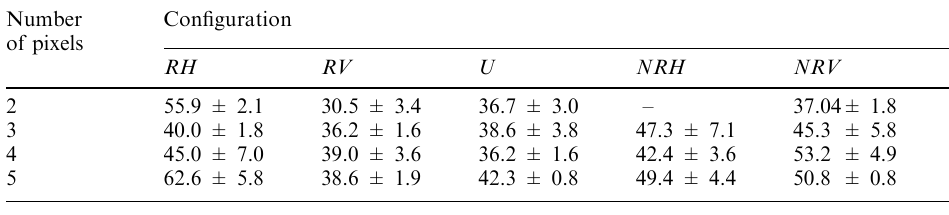
Table 3b. Theoretical average length L and the corresponding standard deviation (in (cid:108) m) for hexagonal columns (note that the volume V of the particle is (cid:129)(cid:129) p 3 given by V (cid:136) 3 L 3 32